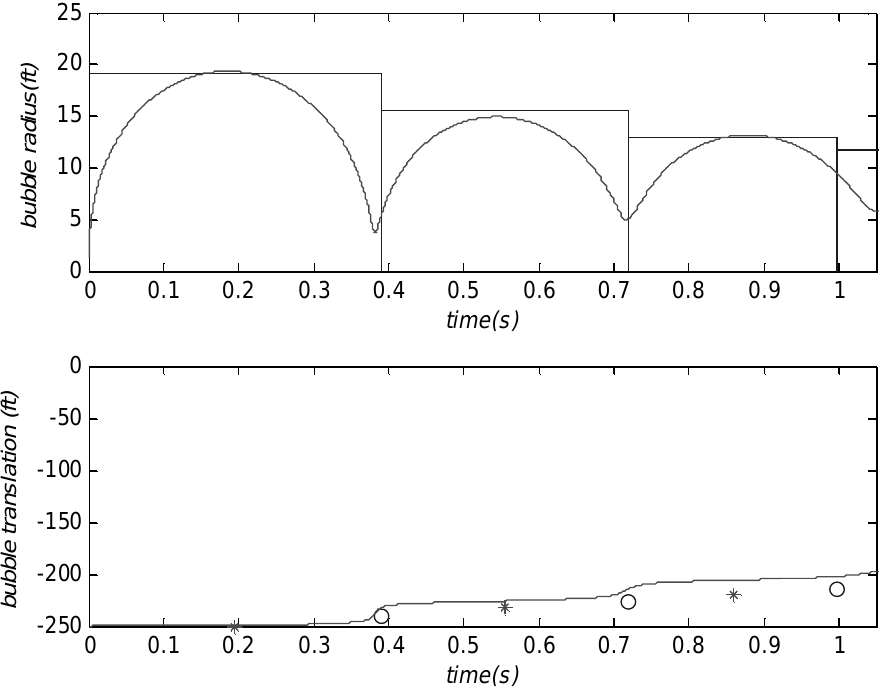
Fig. 3. Dilation and Translation histories for a 1000-lb charge of TNT detonated at a depth of 250 ft, calculated with C = 0.4 and P = 1.0. 100 lb (cid:1) W (cid:1) 1000 lb, d (cid:2) 200 ft is D ( t ) = 0 . 4 | ˙ u ( t ) |